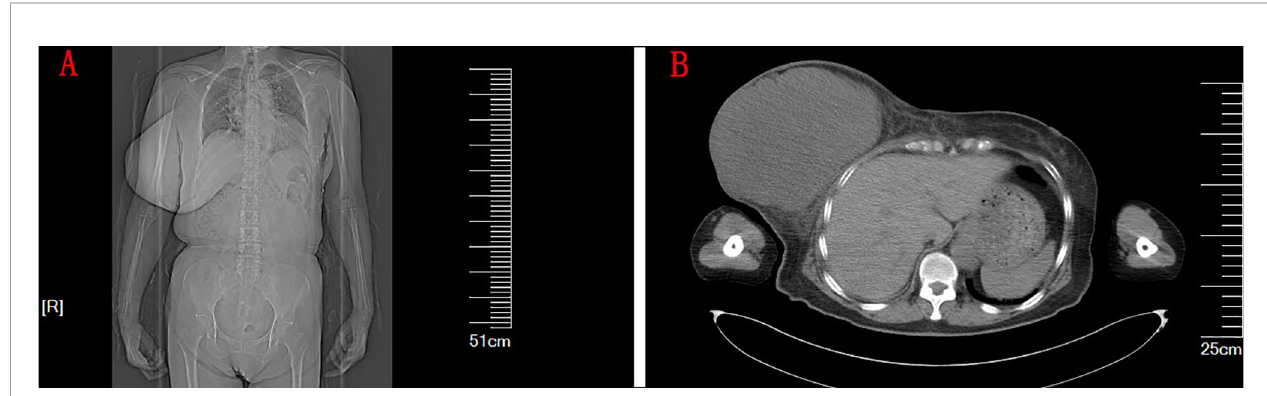
FIGURE 1 | (A) The CT image of the patient ’ s chest and abdomen. (B) The CT of the chest. A large soft tissue density mass was seen in the right breast, measuring approximately 17.1 cm × 13.2 cm × 17.2 cm, with clear borders, regular morphology, and uniform